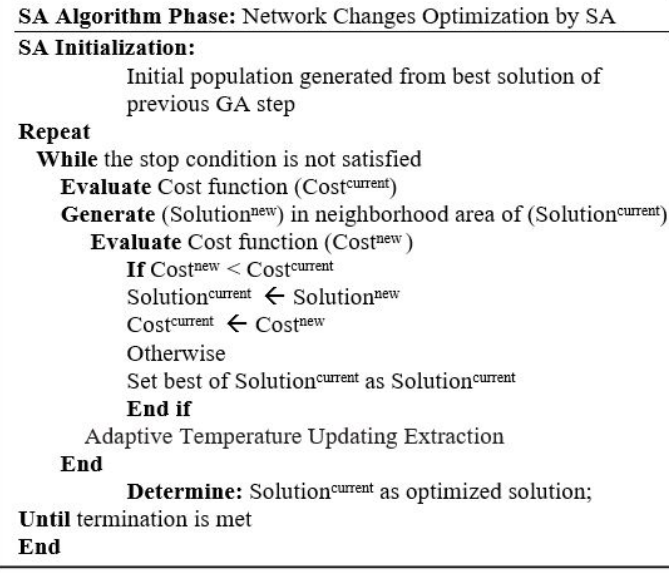
Figure 8. SA Algorithm